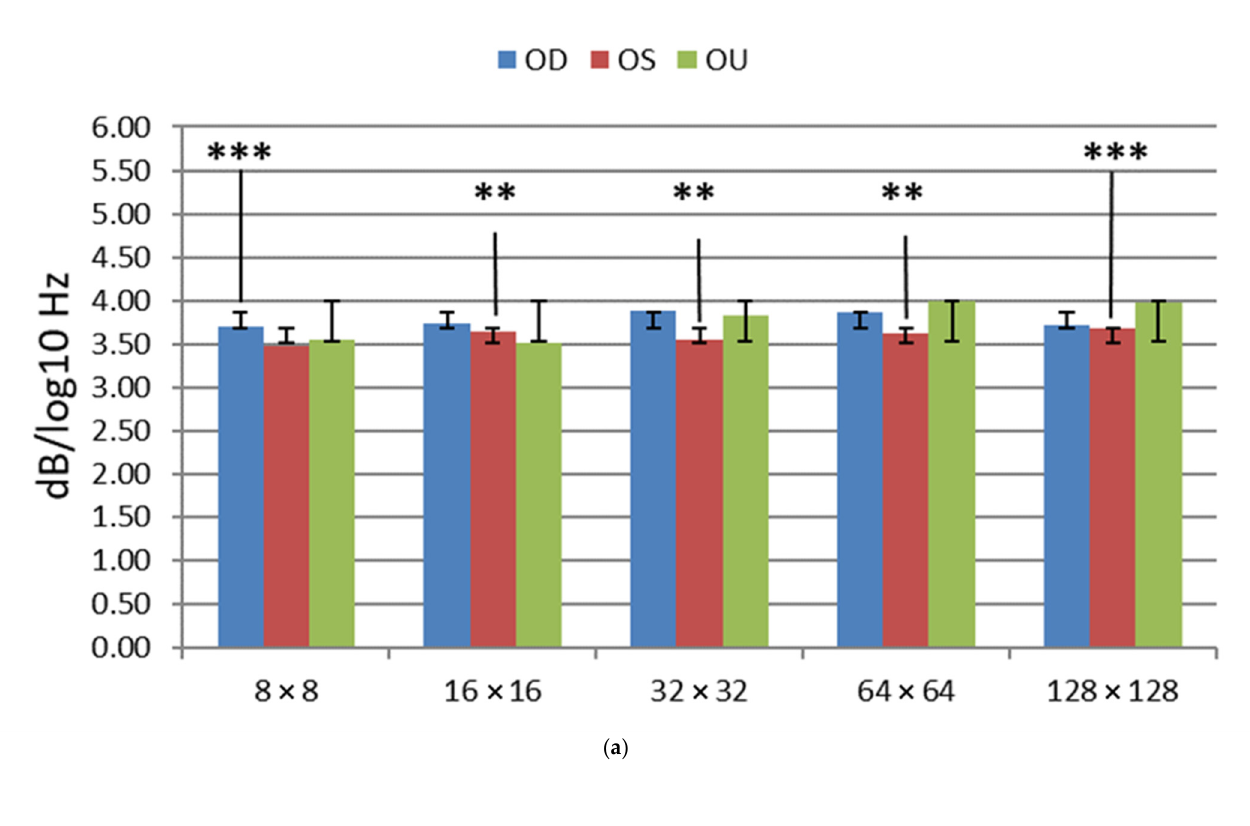
9 Table 3. VEP mean and standard error values, mTBI values and controls. mTBI